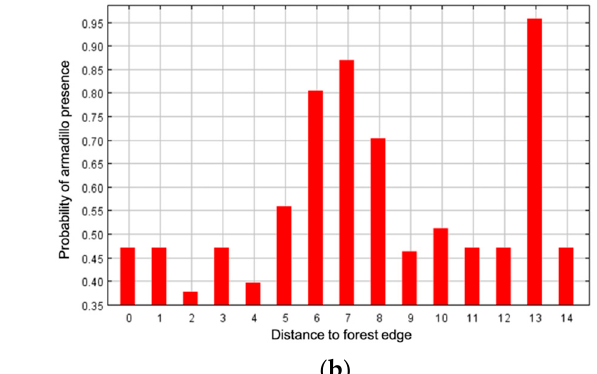
Figure 4. Response curve for land cover type as an environmental predictor for presence of nine-banded armadillo in southern Illinois during 2016–2020. Land cover groups are represented as follows: open water (11), open space development (21), low development (22), medium development (23), high development (24), barren land (31), deciduous forest (41), evergreen forest (42), mixed forest (43), herbaceous (71), hay/pasture (81), cultivated crops (82), woody wetlands (90), and emergent herbaceous wetlands (95). Probability of armadillo presence was highest in open space to medium development, and lowest in agricultural cover.